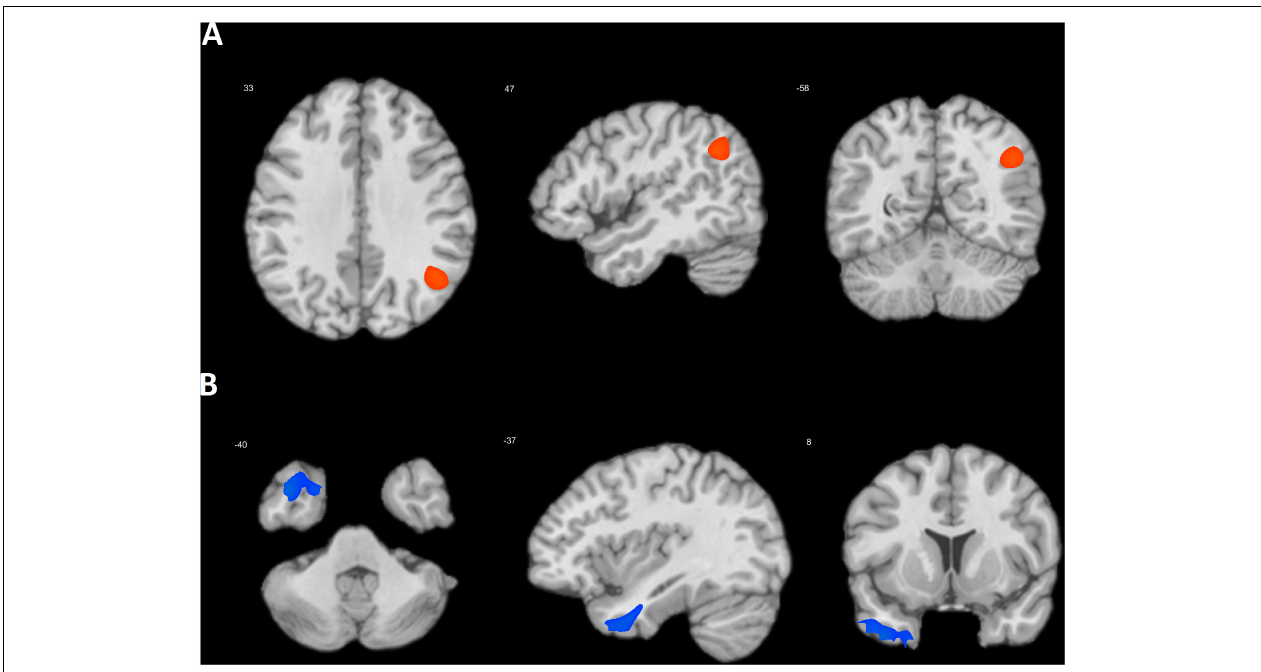
FIGURE 1 | Location of the clusters where the association between DMN connectivity and SRTS scores was higher after collectivism than individualism priming (A) and after individualism than collectivism priming (B) .